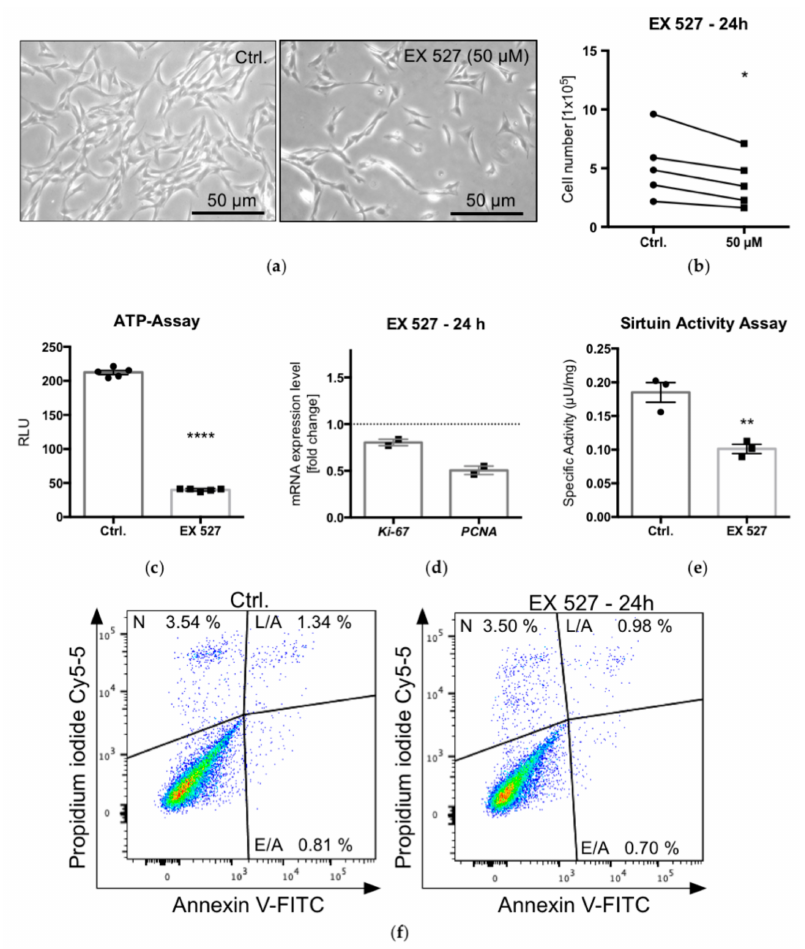
Figure 3. Live cell images of cultured KGN under control conditions (Ctrl) and upon treatment with EX 527 (50 µ M) for 24 h: visibly lower cell number after SIRT1 blockage ( a ). Results of cell counting: the treatment with EX 527 resulted in significantly decreased cell numbers ( n = 5; * p < 0.05; paired t -test) ( b ). ATP assay after EX 527 treatment (50 µ M, 24 h) showed significantly reduced ATP levels in treated cells. Bars represent means and SEMs ( c ) ( n = 5; * p < 0.5, ** p < 0.05, **** p < 0.0005, unpaired t -test). Results of qPCR analysis of proliferation markers Ki-67 and PCNA, normalized to control conditions ( d ) (means and SEMs; n = 2). Results of SIRT activity assay indicated significantly reduced deacetylation activity upon blocker (EX 527 at 50 µ M) treatment ( e ) ( n = 3; unpaired t-test). Effects of EX 527 (50 µ M, 24 h) on apoptosis and necrosis: FACS analysis of KGN ( n = 2), double stained with Annexin V and propidium iodide (PI) ( f ). E/A indicates early apoptotic cells (single stained with Annexin V), L/A indicates late apoptotic cells (double stained with Annexin V and PI) and N indicates necrotic cells (single stained with